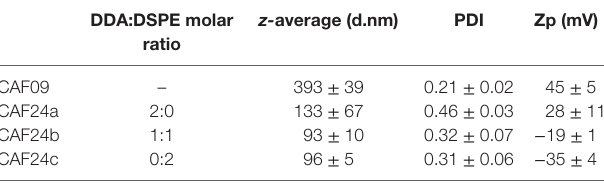
Table 2 | Average hydrodynamic diameter ( z- average, d.nm), PDI, and zeta- potential (zp, mV) of CAF09 and